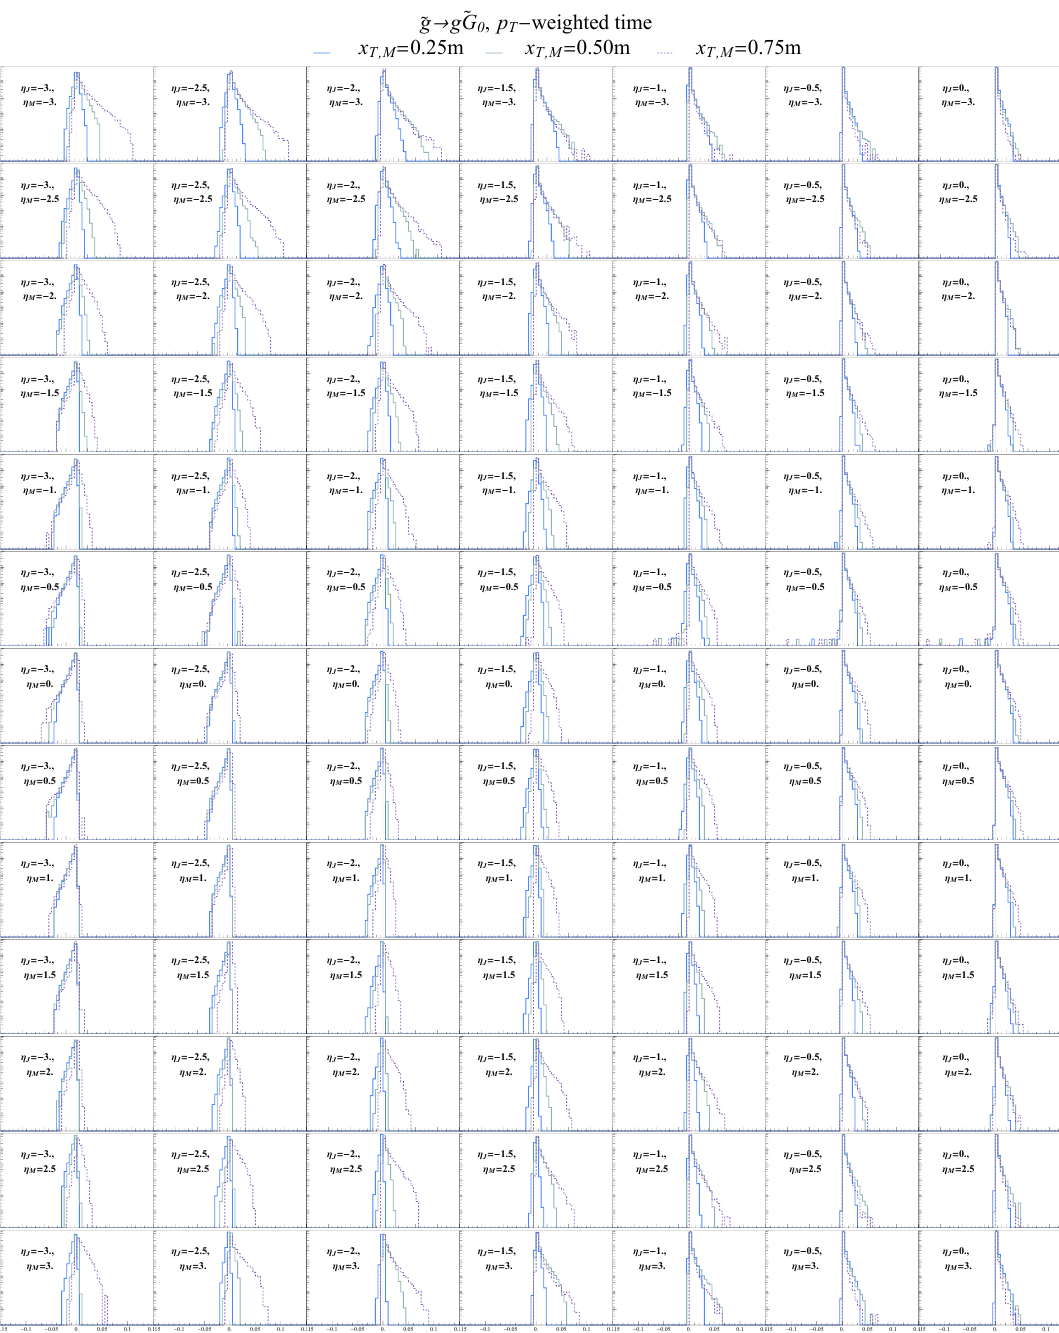
( x -axis) and of η ( y -axis) J M